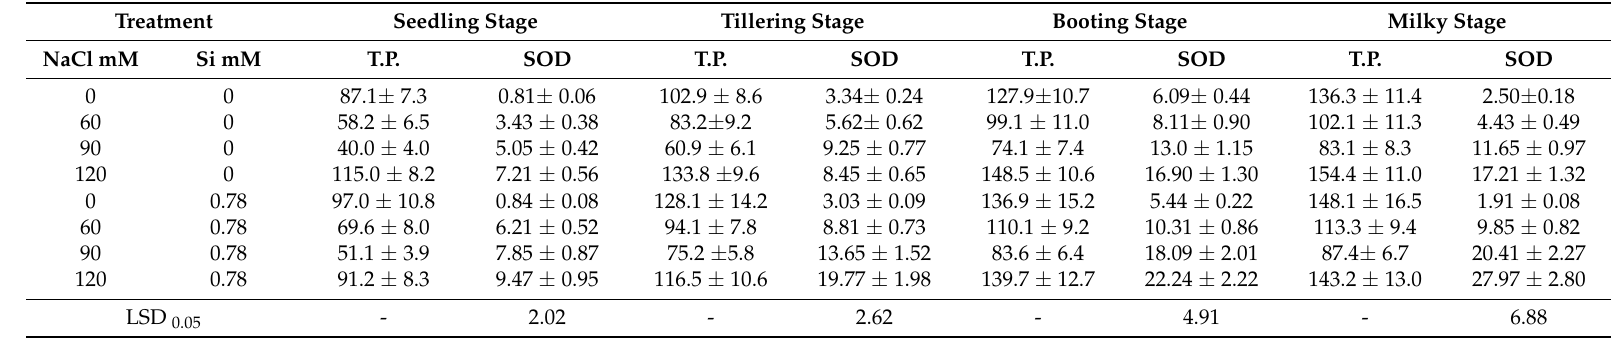
Table 4. Effect of NaCl on total protein, T.P. (mg g − 1 dry matter) and superoxide dismutase (SOD) (Units * mg − 1 T.P.) activity of wheat leaves at different growth stages in the presence and absence of